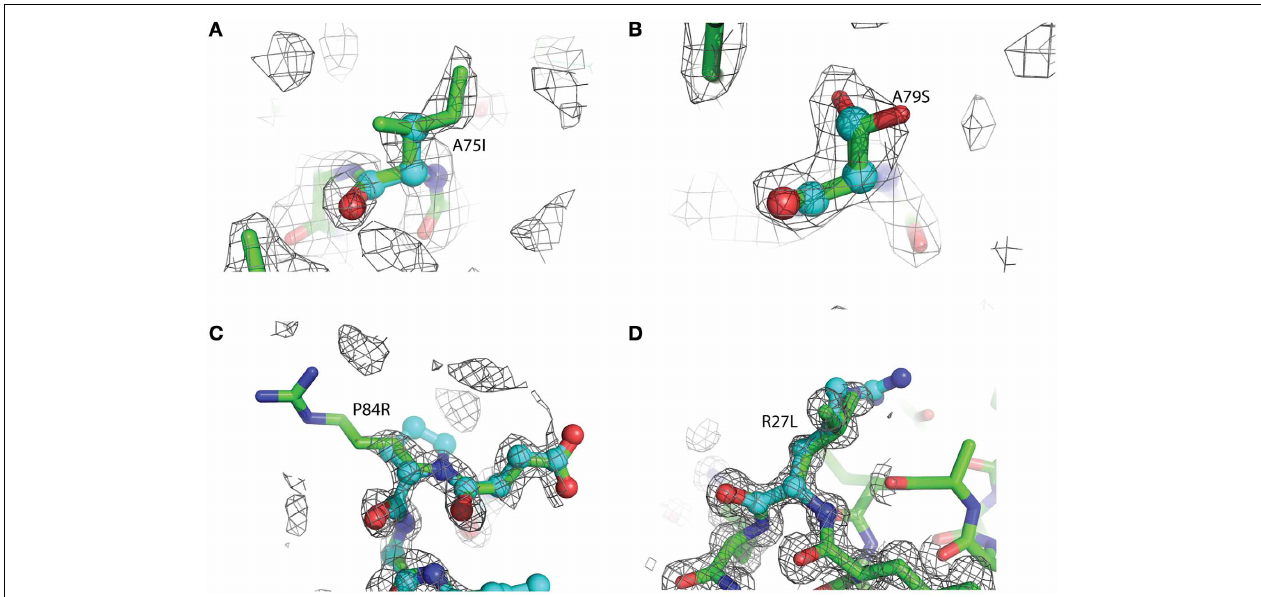
FIGURE 3 | Representative 2Fo-Fc electron density maps, contored at the 1 σ level, of each of the four mutations described. (A) A75I: The wild-type Ala is shown as light blue ball-and-stick, while the mutant Ile is shown as green sticks. The chicken wire shape around the amino acid represents the electron density carved from the final refined structure. (B) A79S: Ala79 is shown as blue balls-and-sticks. The mutant Ser is shown as green sticks. In this case, two conformations of Ser79 can be modeled. Both rotamers were